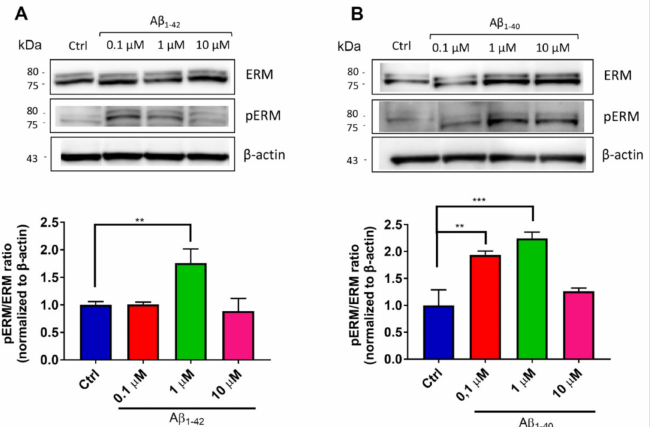
Figure 6. Expression of the ezrin–radixin–moesin (ERM) protein complex by hCMEC/D3 cells after exposure to A β . To set up an in vitro model of the blood–brain barrier (BBB), cerebral microvascular endothelial cells were seeded on transwell inserts. After 6 days of culture, different concentrations (from 0.1 to 10 µ M) of A β 1-42 ( A ) or A β 1-40 ( B ) oligomers were incubated in the apical compartment of the transwell system for 24 h. Then, proteins were extracted and analyzed by SDS-PAGE/WB, followed by immunoblotting of ERM proteins and its phosphorylated form (pERM). The intensity of chemiluminescent bands was estimated by Amersham 600 and normalized to β -actin. Representative blots are shown. Data are expressed as mean ± SD from three independent experiments. Statistical analysis was performed using one-way ANOVA: ** p < 0.01; *** p <